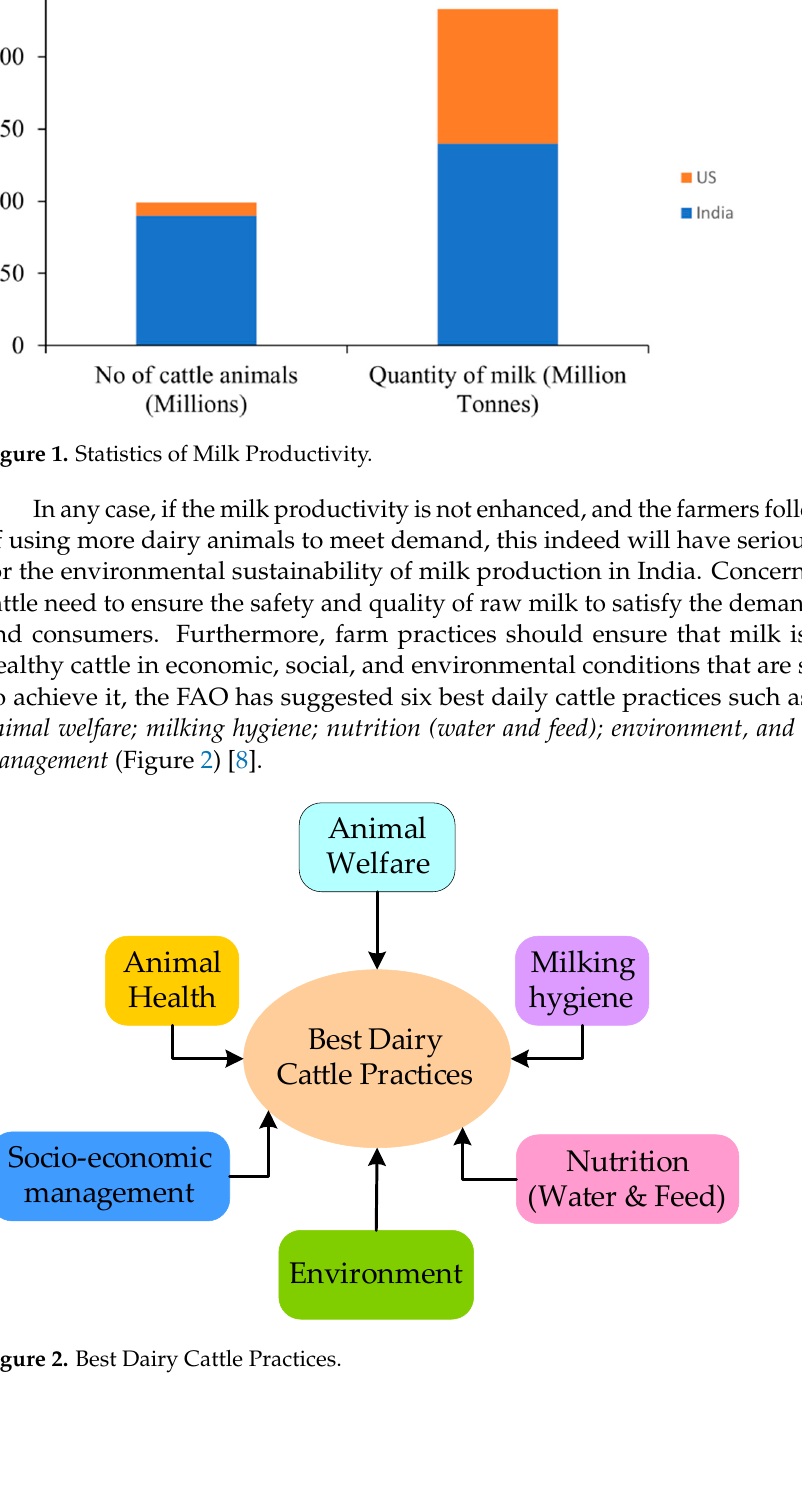
Figure 2. Best Dairy Cattle Practices.